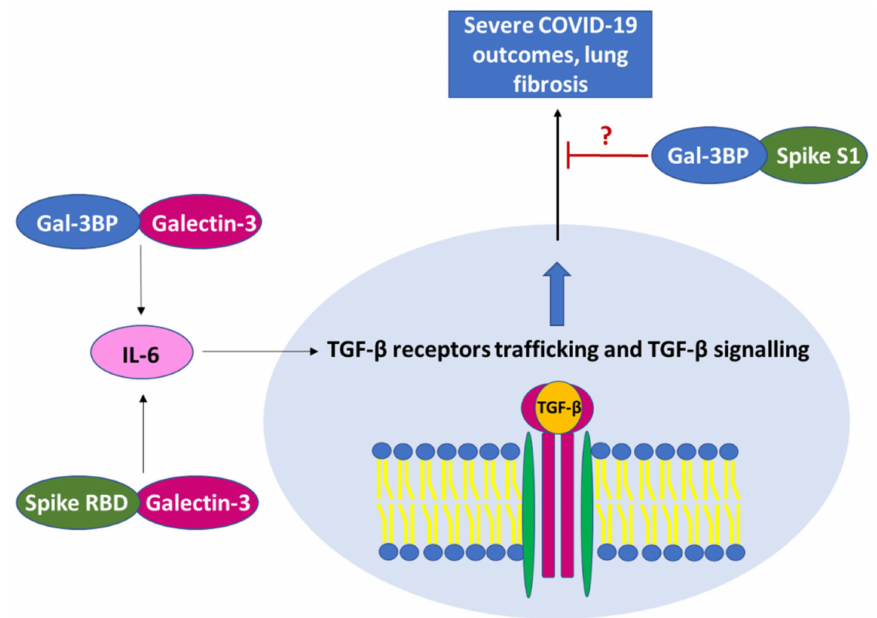
Figure 4. Schematic representation of the possible significance of the interaction between the spike RBD glycans and galectin-3 and between the S1 subunit of spike protein and Gal-3BP in miming and/or blocking the Gal-3BP/galectin-3 signaling. Gal-3BP/galectin-3 interaction leads to increased expression and secretion of IL-6, which has been demonstrated to increase TGF- β signaling and play a role in the development of fibrosis. This profibrotic mechanism resembles that mediated by SARS-CoV-2; indeed, the interaction of Spike RBD glycans with galectin-3 has been demon- strated to upregulate IL-6. This led us to hypothesize that SARS-CoV-2 spike could mimic the Gal-3BP/galectin-3 signaling. Furthermore, in vitro studies demonstrated the possible interaction between Gal-3BP and the S1 galectin-like domain of the spike protein. While there is strong evidence of the antiviral significance of this interaction (see the main text for further details), no studies have been conducted to demonstrate the possibility that it could also act differently. However, the findings of Gal-3BP/S1 spike interaction suggest that it could block the Gal-3BP signaling and the detrimental outcomes of severe COVID-19; thus, we believe that it might be interesting to consider this for further